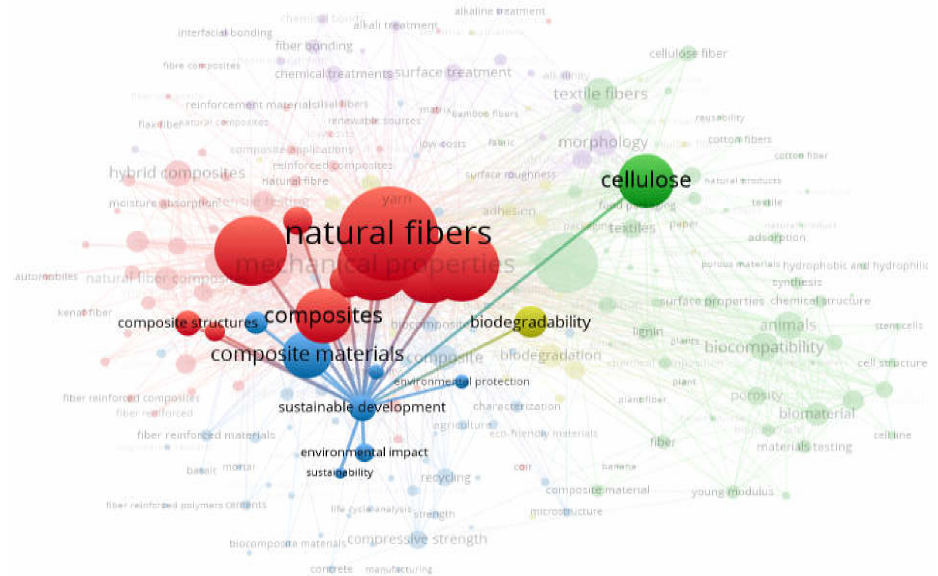
Figure 6. Sustainable development linkage with all factors.